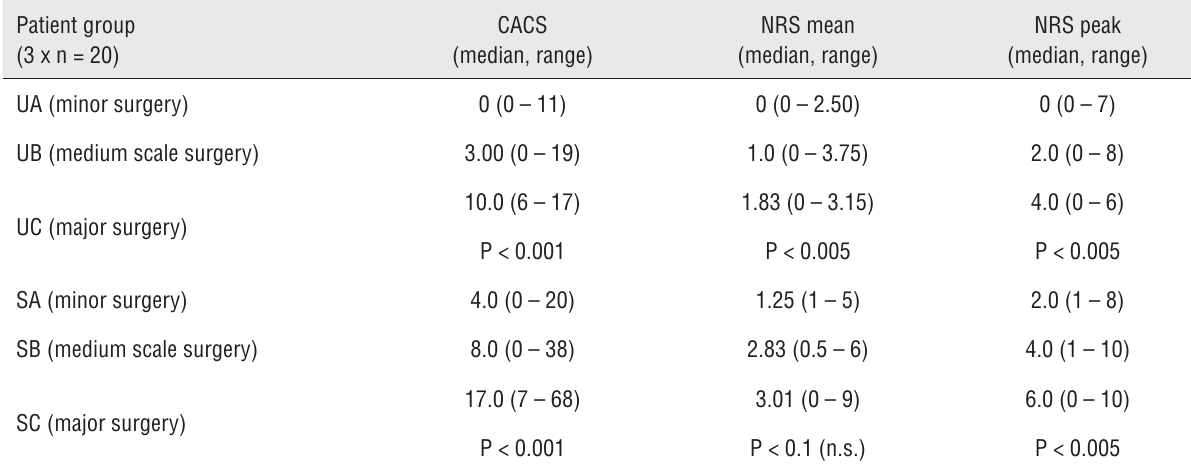
Table 1 - CACS values and corresponding NRS values for pain (urological and surgical patients). Patient